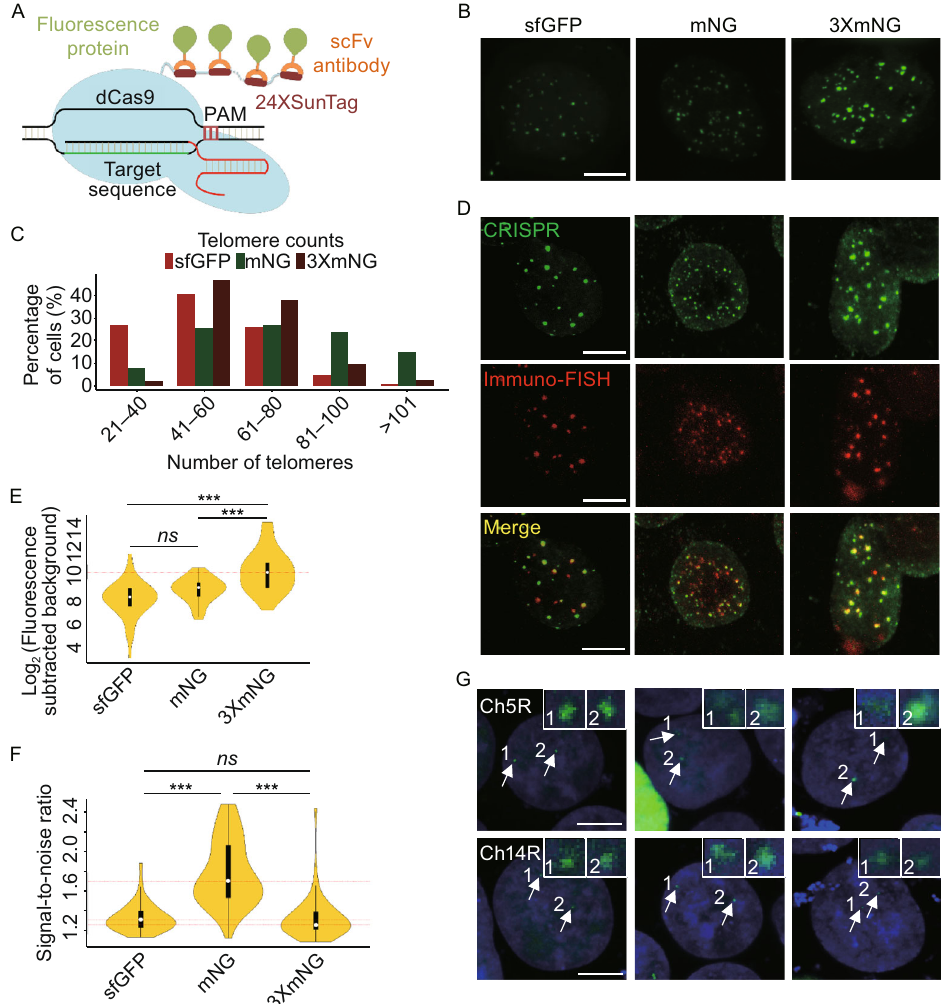
Figure 1. Live cell imaging of genomic loci using dCas9-SunTag system and a bright fl uorescent protein . (A) Schematic of dCas9-SunTag system combined with sfGFP, mNeonGreen (mNG) or 3XmNeonGreen (3XmNG). (B) Visualizing human telomeres with CRISPR/Cas9 system using different fl uorescent proteins. HEK293Tcells were transfected with sgTelomere and dCas9-SunTag system combined with sfGFP, mNeonGreen and 3XmNeonGreen, respectively. 48 h after transfection, cells were imaged by confocal laser scanning microscope. Scale bar, 2 μ m. (C) Histogram of telomere punta counts per cell detected by sfGFP, mNeonGreen, and 3XmNeonGreen (N = 66, 62, and 60 cells, respectively). (D) Co-localization of telomeres using sfGFP, mNeonGreen, 3XmNeonGreen (top), and FISH (middle). Scale bar, 5 μ m. (E and F) CRISPR fl uorescence intensity and signal-to-noise ratio of labelled telomere foci. N = 50 cells for each analysis and the dot within the vioplot represents the median value. (G) Two low-repeat genomic loci were labeled with different fl uorescence proteins. Ch5R and Ch14R sites contain 21 and 15 copies of repeats, respectively. The experiment procedure is similar to telomere labeling. Nuclei were counterstained with the live staining dye Hoechst33342. Scale bar, 5 μ m. All images are achieved by maximum intensity projections from tracking with different fl uorescent proteins revealed that the the other two ( P < 0.001), while there was no statistical telomere movement is con fi ned diffusion (Fig. S1A and signi fi cant difference between sfGFP and mNeonGreen Movies S4, S5 and S6). To test whether the CRISPR (Fig. 1E). And the foci in cells expressing mNeonGreen approaches could be applied to image low-repeat chromo- showed higher signal-to-noise ratio than that in cells some loci, the program Tandem Repeat Finder was expressing the other two fl uorescent proteins (Fig. 1F). To employed to fi nd repeat sequences in human genome interrogate intranuclear dynamics of telomeres in living cells, (Benson, 1999), and a locus containing 21 copies of exact time-series about the movement of telomeres were acquired repeats on chromosome 5 (Ch5R), and a locus containing 15 simultaneously by time-lapse microscopy. Single-particle